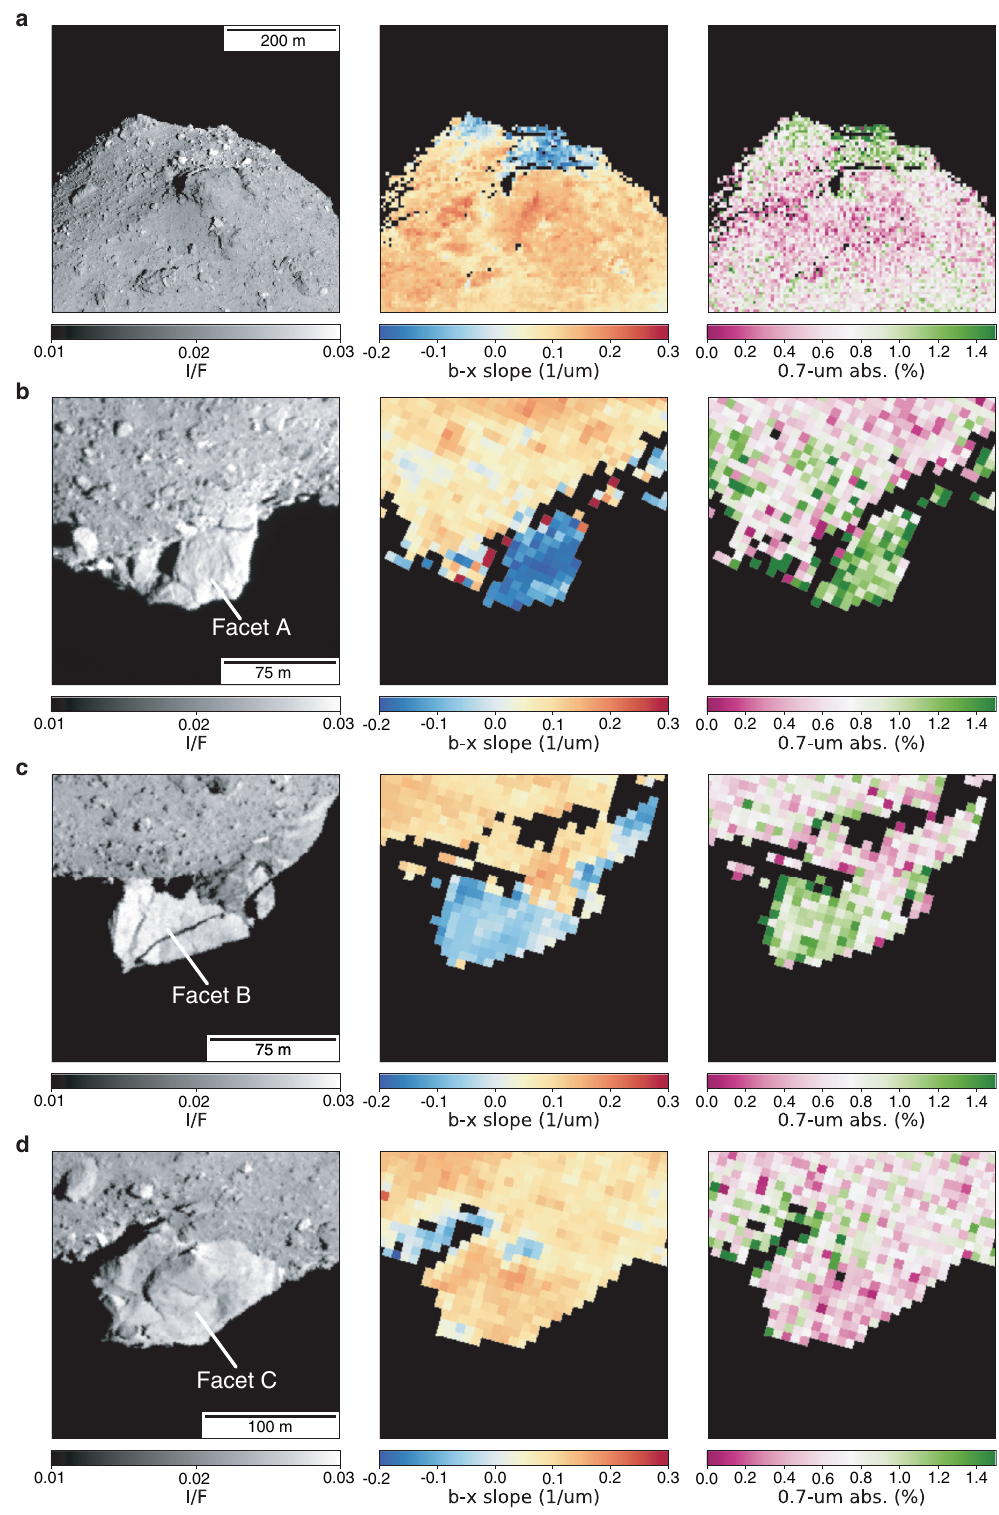
Fig. 1 I/F and color index maps of the both polar regions. a North pole. b – d Otohime Saxum at south pole ( b : Facet A, c : Facet B, d : Facet C); (Left) radiance factor (I/F) images, (Middle) b – x (0.48 – 0.86 µ m) spectral slope map, (Right) 0.7- µ m absorption depth map. Image ids used for this fi gure are listed in Supplementary Table